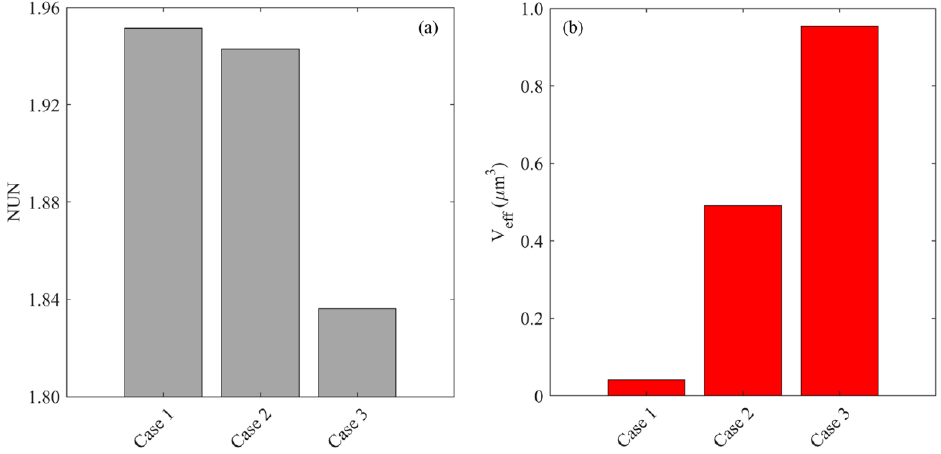
Figure 15. Impacts of the plasma volume fraction of infusion site on ( a ) drug distribution, and ( b ) treatment effectiveness in the brain tumor. The results are taken on Day 3.